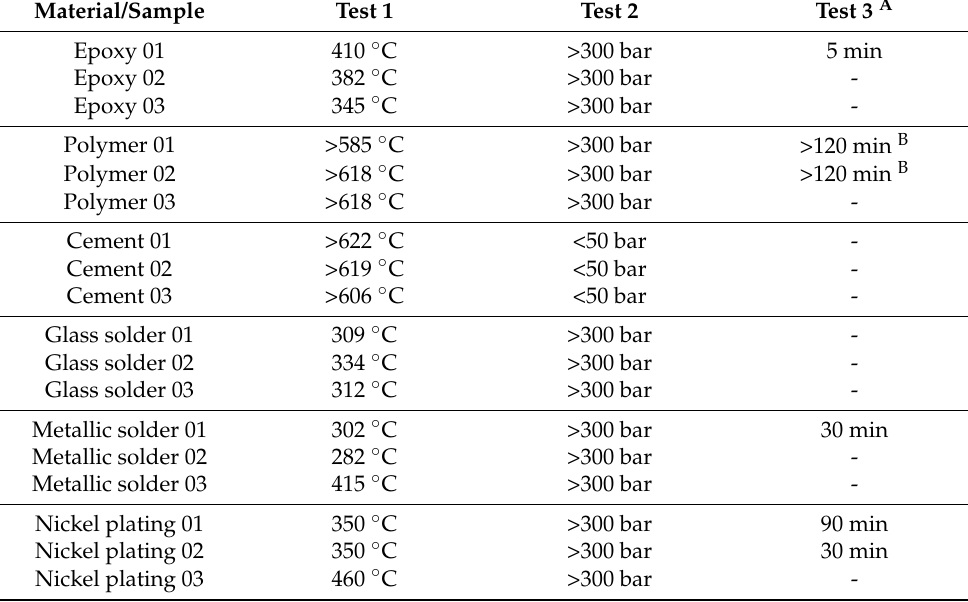
Table 1. Results for endurance, leakage and field-testing.